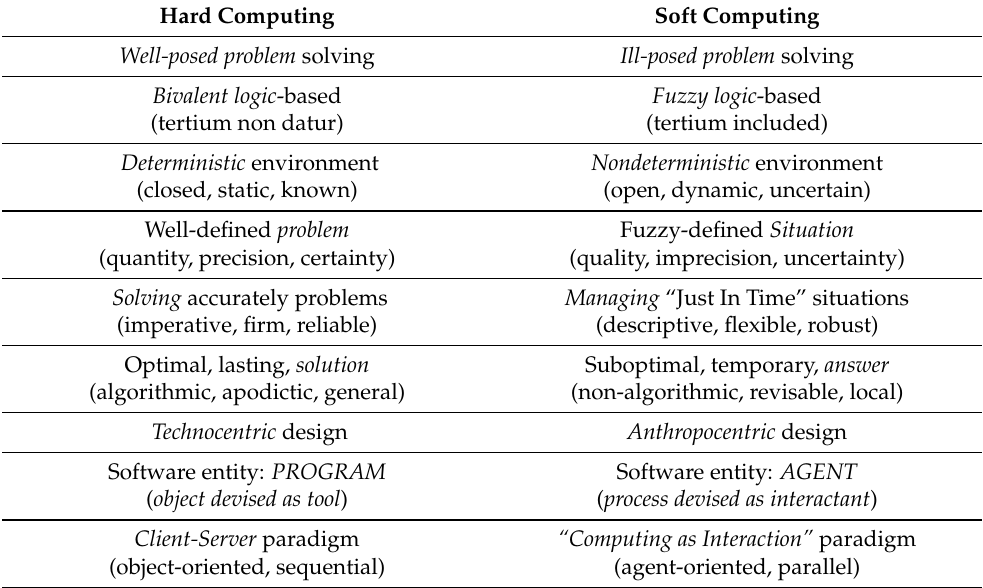
Table 1. Hard Computing vs. Soft